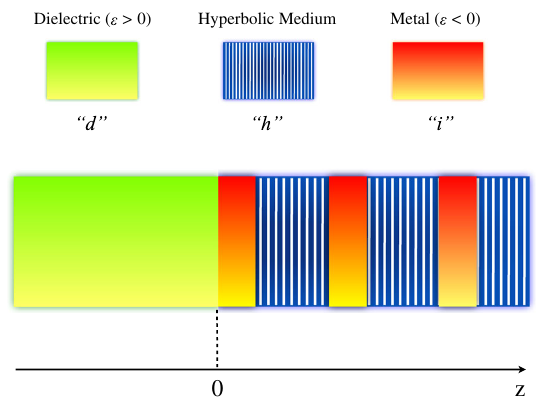
FIG. 7. The interface of a “ metallic ” hypercrystal and a dielectric. The hypercrystal is terminated at the metallic layer. The symbols in quotation marks show the corresponding sub- scripts in Sec.